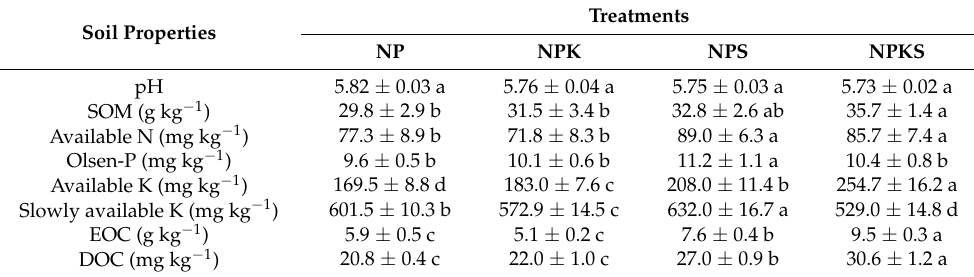
Table 2. Effects of straw incorporation and K fertilizer on soil properties in the bulk soils.